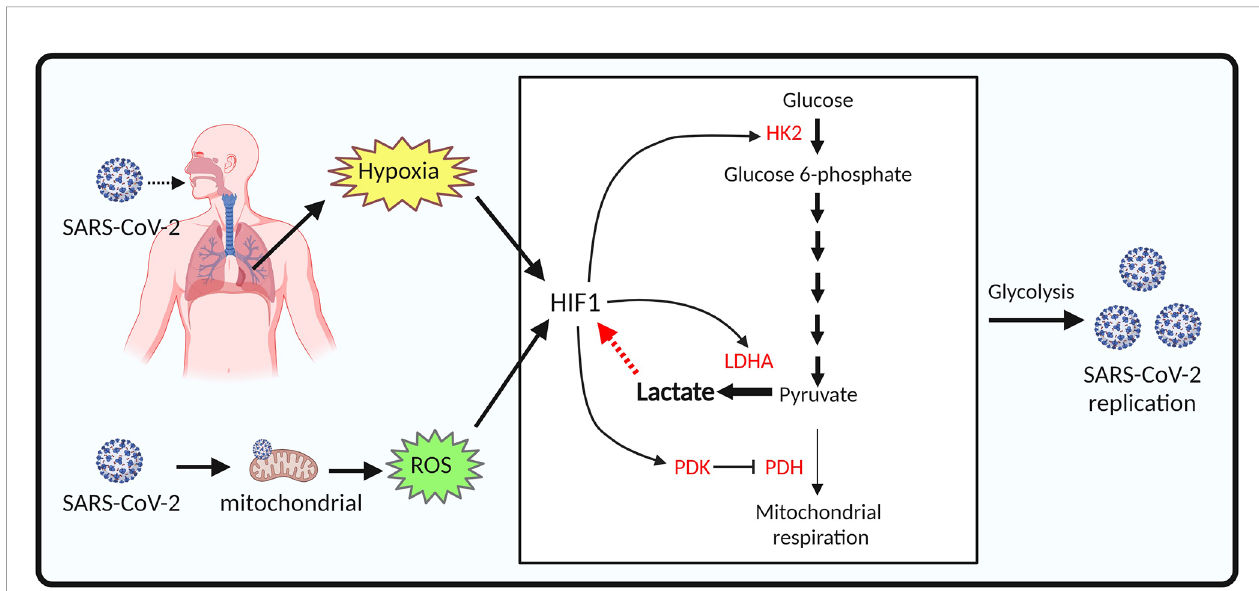
FIGURE 1 | Proposed model of aerobic glycolysis activation in SARS-CoV-2 infected endothelial cells. SARS-CoV-2 infection of pulmonary tissues leads to hypoxia. SARS-CoV-2 infection also causes mitochondrial dysfunction and reactive oxygen species (ROS) production in endothelial cells. Both hypoxia and ROS mediate